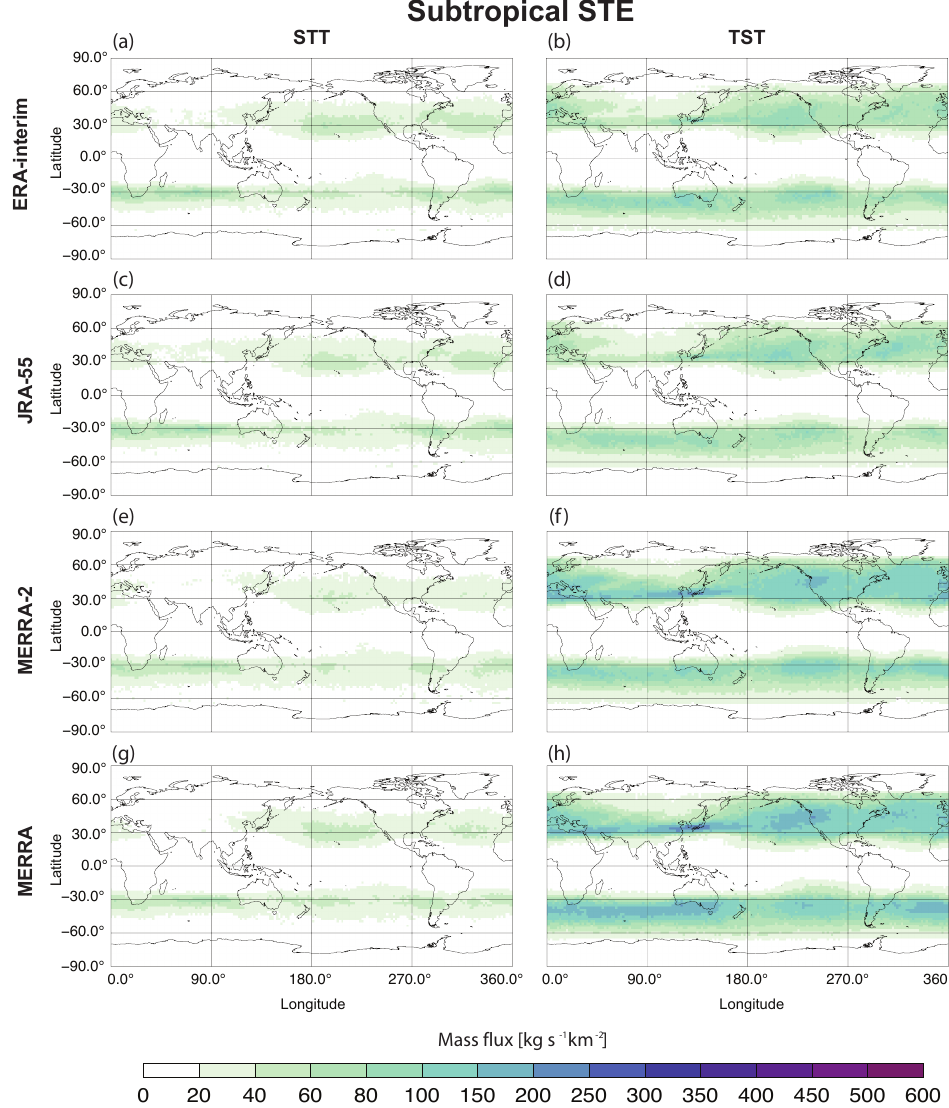
Figure 7. The same as in Fig. 4 but for STE in the subtropics.